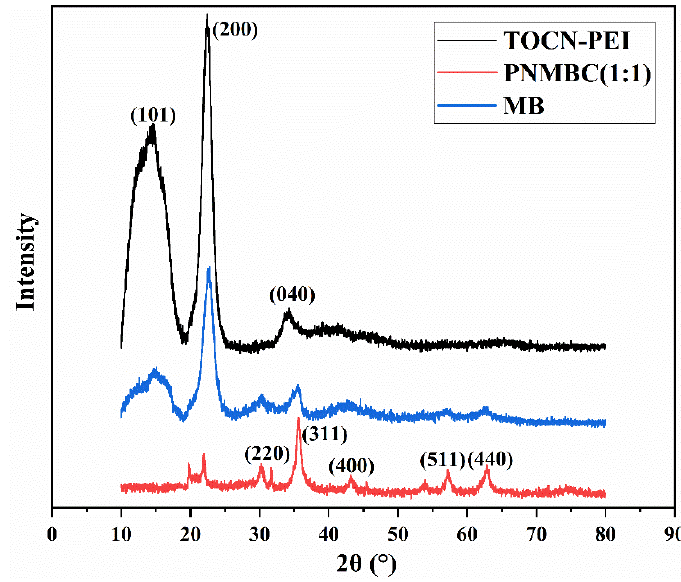
Figure 3. XRD results of the PEI-modified nanocellulose and prepared composites.